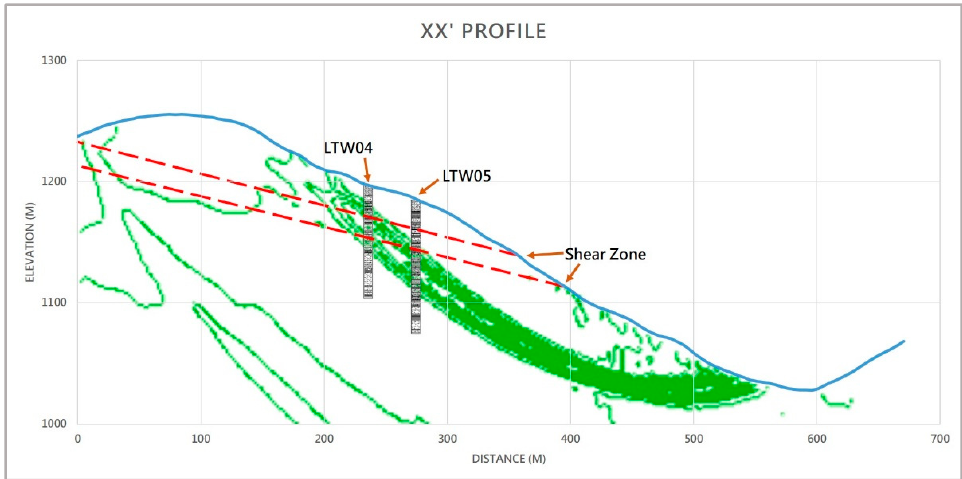
Figure 17. The distribution of the maximum shear strain increment plotted as contours, and compared to the borehole loggings and shear zone. The potential sliding surface appeared to pass through the shear zone material indicated as black legend for the loggings, and shear zone passed through shear zone material in the upper part of logging.